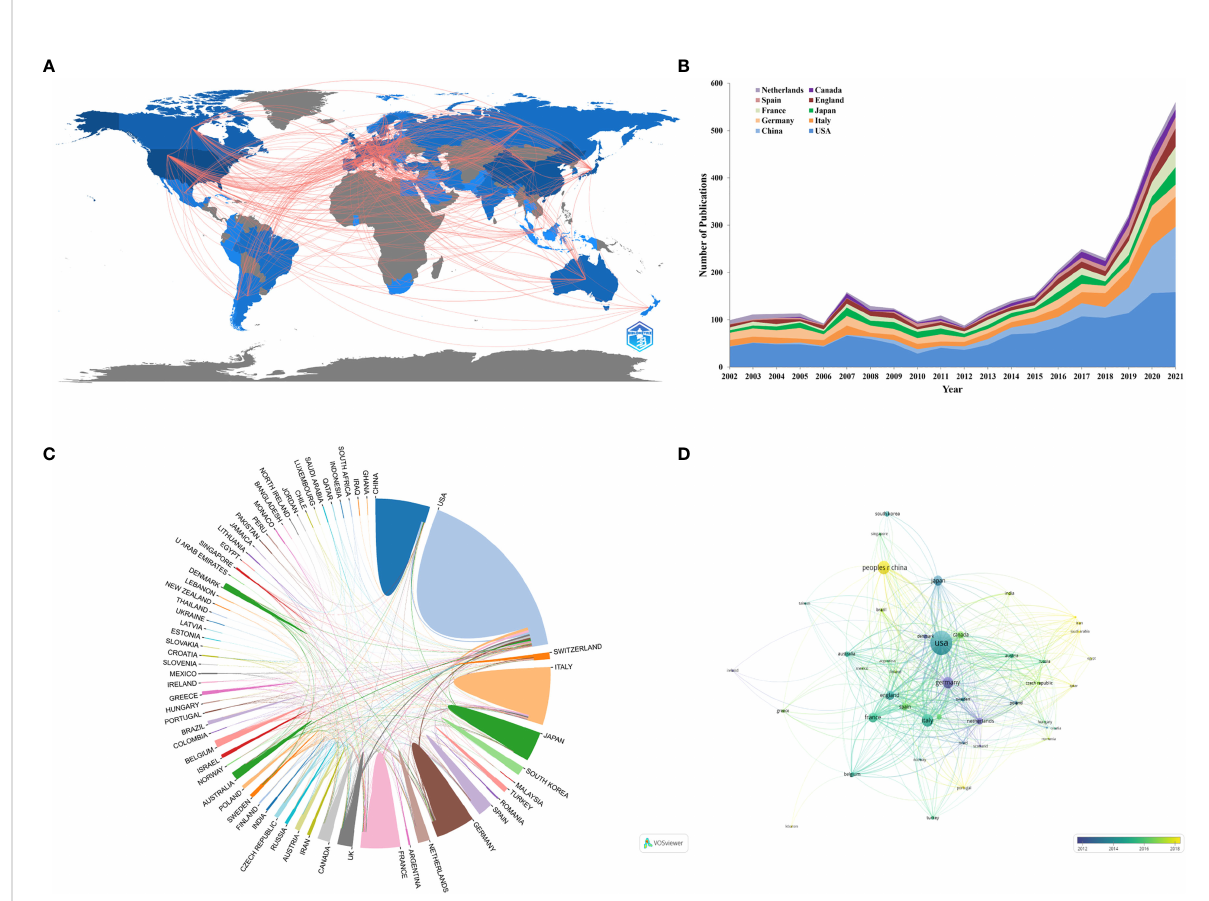
FIGURE 3 (A) Geographic distribution map based on the total publications of different countries/regions. (B) The changing trend of the annual publication quantity in the top 10 countries/regions from 2002 to 2021. (C) The international collaborations visualization map of countries/regions. (D) The countries/regions citation overlay visualization map generated by using VOSviewer. Each node means a country/region, and the size of node indicates the number of publications. The connection between the nodes represents the citation relationship, and the thickness of the connection lines indicates citation strength.